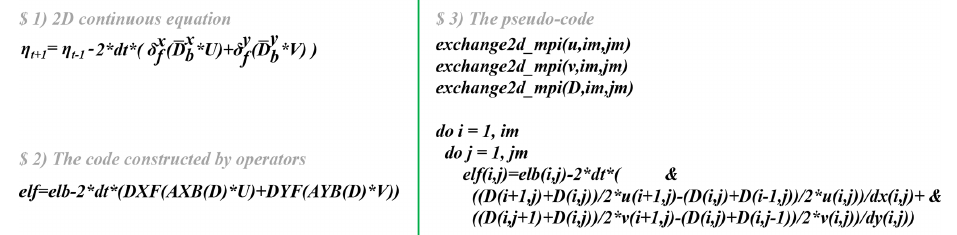
Figure 2. Implementation of Eq. (6) by basic operators. The elf and elb variables are the surface elevations at times ( t + 1) and ( t − 1),